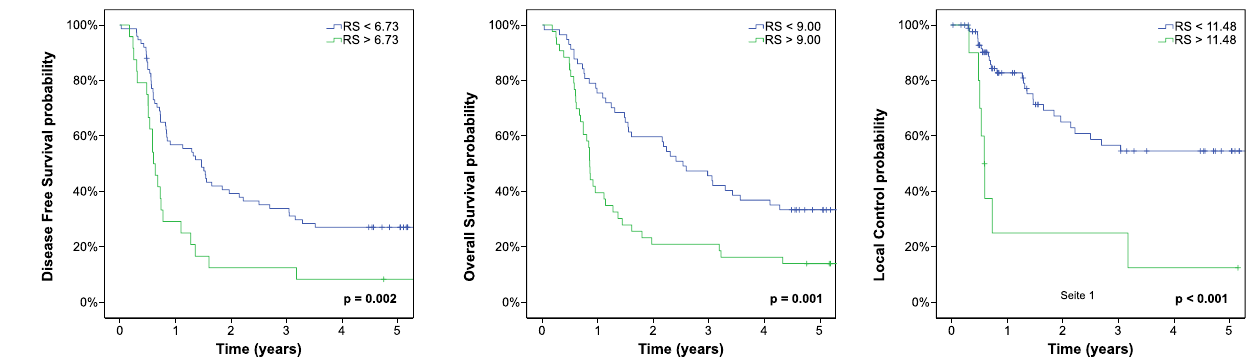
Figure 1. Training cohort. Kaplan–Meier estimates with prognostic groups split by endpoint-specific radiomics signatures (RS) into high and low-risk Here we were able to demonstrate that a pre-therapeutic radiomics signature is able to identify patients at risk for early tumor recurrence or death. The prognostic value was externally validated when using a pre-specified cutoff value. This is a remarkable finding since patients´ characteristics and treatment between participating centers differed considerably. However the prognostic value for the calculated signature could not be validated by non-dichotomized cox-regression. In addition the radiomics signatures failed in the further investigated